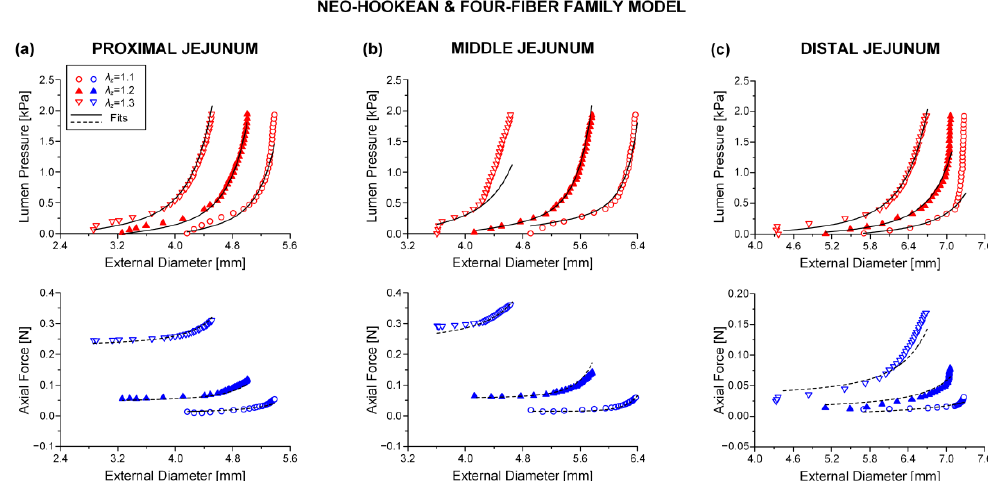
Figure 3. Plot of measured lumen pressure (red color) and axial force (blue color) vs. external diameter data at three different fixed axial stretches 𝜆 𝑧 = {1.1, 1.2, 1.3} for a characteristic specimen from the proximal, middle, and distal jejunum and fits (solid lines for lumen pressure and dashed lines for axial force) calculated using the neo-Hookean and four-fiber family microstructure-based model of Equation (1) with the following best-fit model parameters for the ( a ) proximal jejunum: 𝜇 = 7.0 × 10 −12 kPa, 𝑘 1𝑑 = 3.121 kPa, 𝑘 2𝑑 = 9.743, 𝑘 1𝑎 = 25.331 kPa, 𝑘 2𝑎 = 3.590, 𝑘 1𝑐 = 1.7 × 10 −10 kPa, 𝑘 2𝑐 = 1.662, 𝑎 0 = 0.691 rad, ε = 0.239, 𝑅 2 = 0.927, 𝑑𝑒𝑡(𝐑) = 2.9 × 10 −5 , ( b ) middle jejunum: 𝜇 = 1.7 × 10 −13 kPa, 𝑘 1𝑑 = 0.150 kPa, 𝑘 2𝑑 = 7.627, 𝑘 1𝑎 = 4.723 kPa, 𝑘 2𝑎 = 3.307, 𝑘 1𝑐 = 0.115 kPa, 𝑘 2𝑐 = 3.1 × 10 −7 , 𝑎 0 = 0.310 rad, ε = 0.312, 𝑅 2 = 0.871, 𝑑𝑒𝑡(𝐑) = 1.5 × 10 −4 , and ( c ) distal jejunum: 𝜇 = 4.7 × 10 −12 kPa, 𝑘 1𝑑 = 1.237 kPa, 𝑘 2𝑑 = 5.379, 𝑘 1𝑎 = 1.264 kPa, 𝑘 2𝑎 = 0.944, 𝑘 1𝑐 = 2.4 × 10 −10 kPa, 𝑘 2𝑐 = 0.662, 𝑎 0 = 0.692 rad, ε = 0.342, 𝑅 2 = 0.824, 𝑑𝑒𝑡(𝐑) = 7.1 × 10 −4 . Data are shown every 0.5 mmHg for clarity.